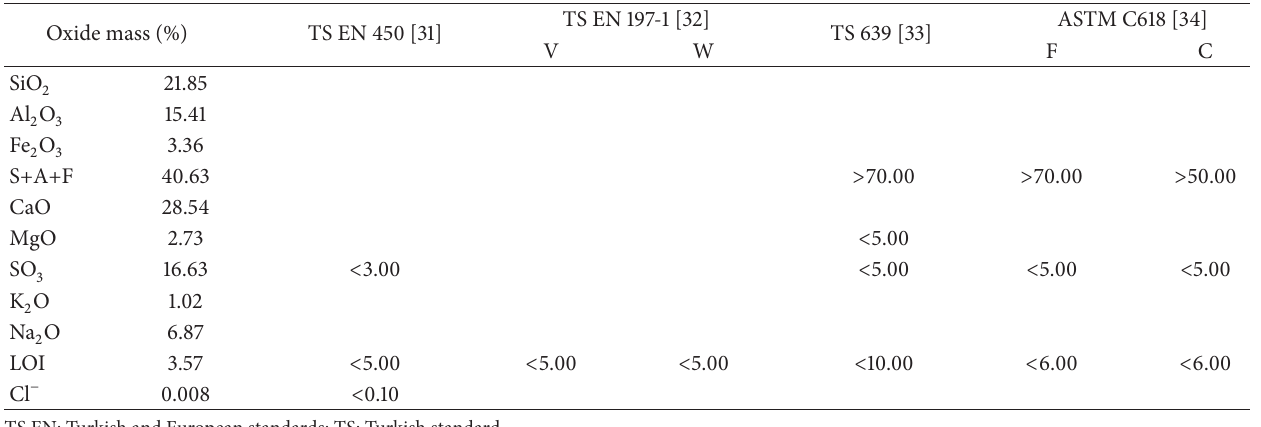
Table 2: Standards compliance limits.